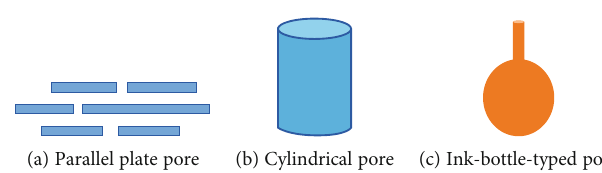
Figure 9: Pore shapes corresponding of the adsorption